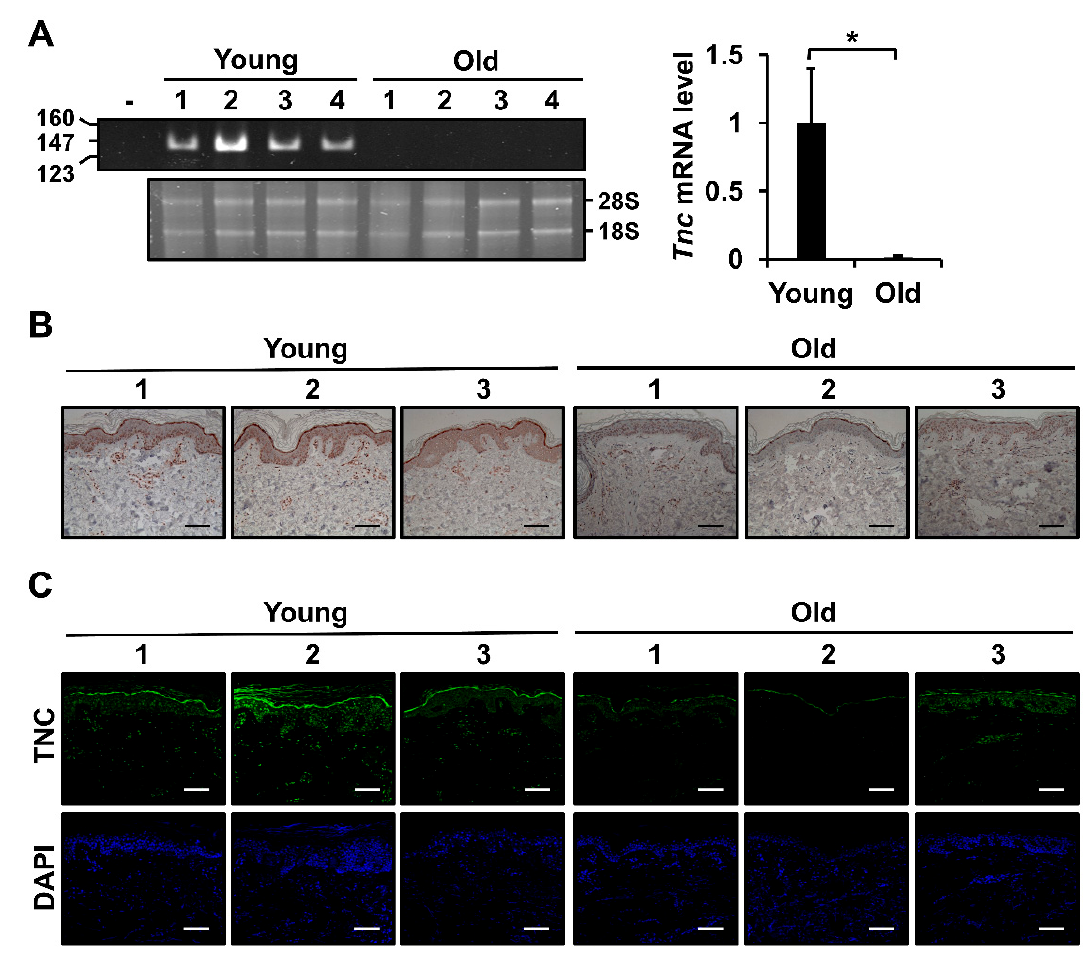
Figure 1. Analysis of tenascin C (TNC) expression in skin tissues from young and old mice and humans. ( A ) Tnc mRNA level was analyzed in mouse skin tissues by reverse transcription-polymerase chain reaction (RT-PCR). The panel on the right shows a graphical presentation of Tnc mRNA levels in mouse skin tissues quantified using multi-gauge densitometry software. Tnc mRNA level relative to that in skin tissues of young mice (n = 4) is shown as mean ± SD. * p < 0.05. -: no template as a negative control. ( B , C ) Immunohistochemical (IHC) ( B ) and immunofluorescence (IF) ( C ) analyses of TNC protein level in skin tissues from young and elderly human subjects. Sections of skin tissues were incubated with TNC antibody. For IHC, the specimens were stained with horseradish peroxidase-conjugated secondary antibody and 3-amino-9-ethylcarbazole and counterstained with hematoxylin. For IF, the specimens were incubated with secondary antibody conjugated with Alexa Flour 488 (green) and counterstained with 4 ′ ,6-diamidino-2-phenylindole (DAPI) (blue). Magnification, × 200. Bar = 100 µm.